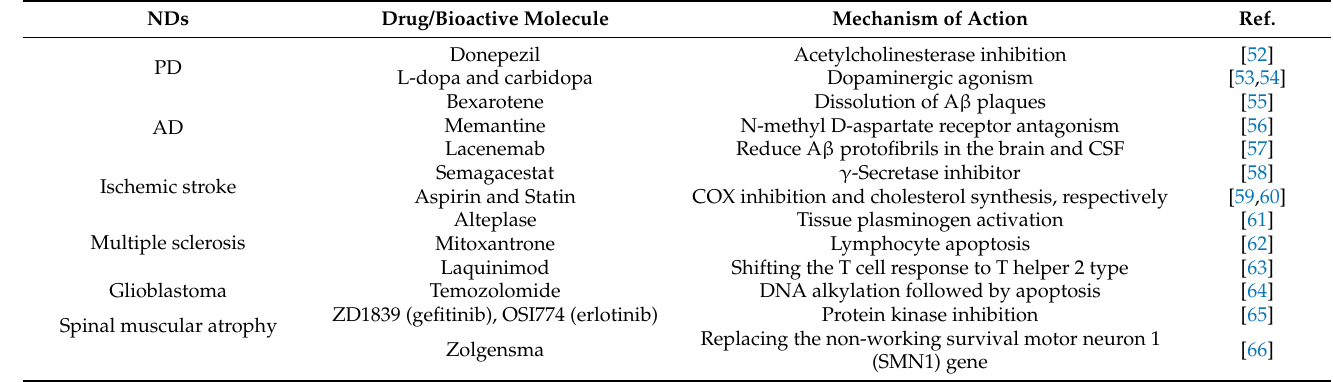
Table 1. List of the therapeutic drugs used in the treatment of NDs and their modes of